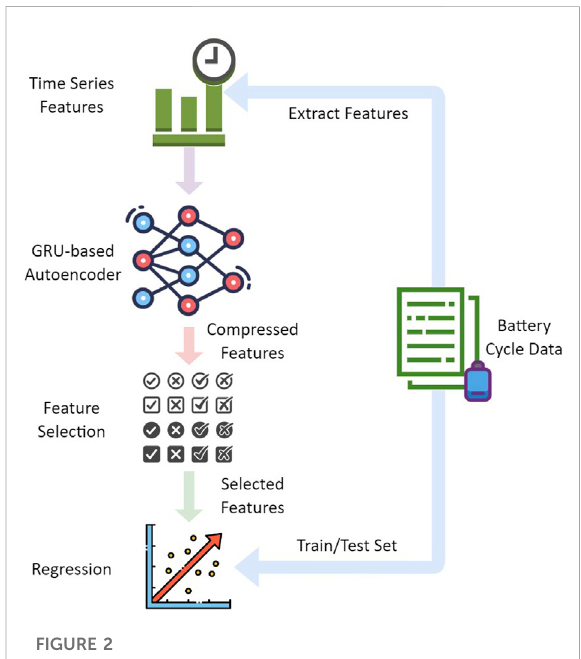
FIGURE 2 The two-stage data-driven feature engineering framework for the early-stage battery lifetime